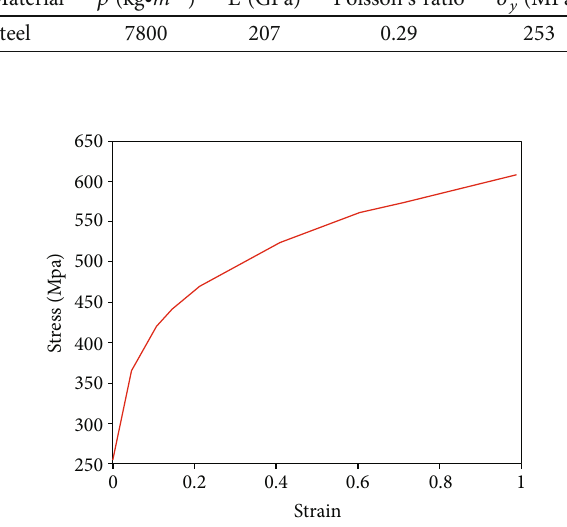
Figure 7: Stress-strain curve of the